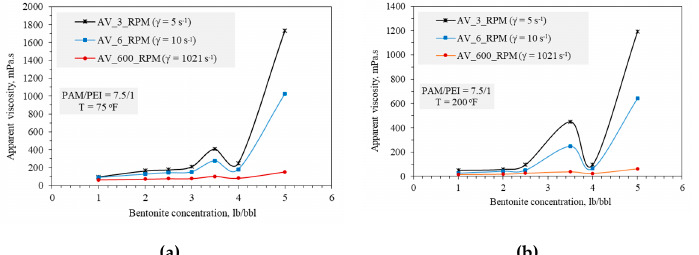
Figure 5. Impact of bentonite concentration on AV of the 7.5 wt.% PAM/PEI ‐ based drilling fluid at (a) 75 o F and (b) 200 °F.